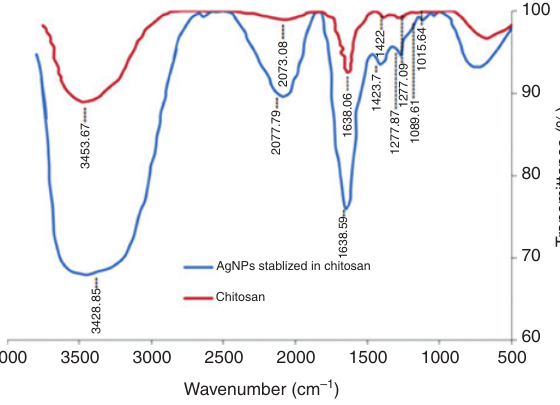
Figure 3: Fourier transform infrared (FT-IR) spectrum of chitosan and chitosan containing silver nanoparticles (AgNPs).